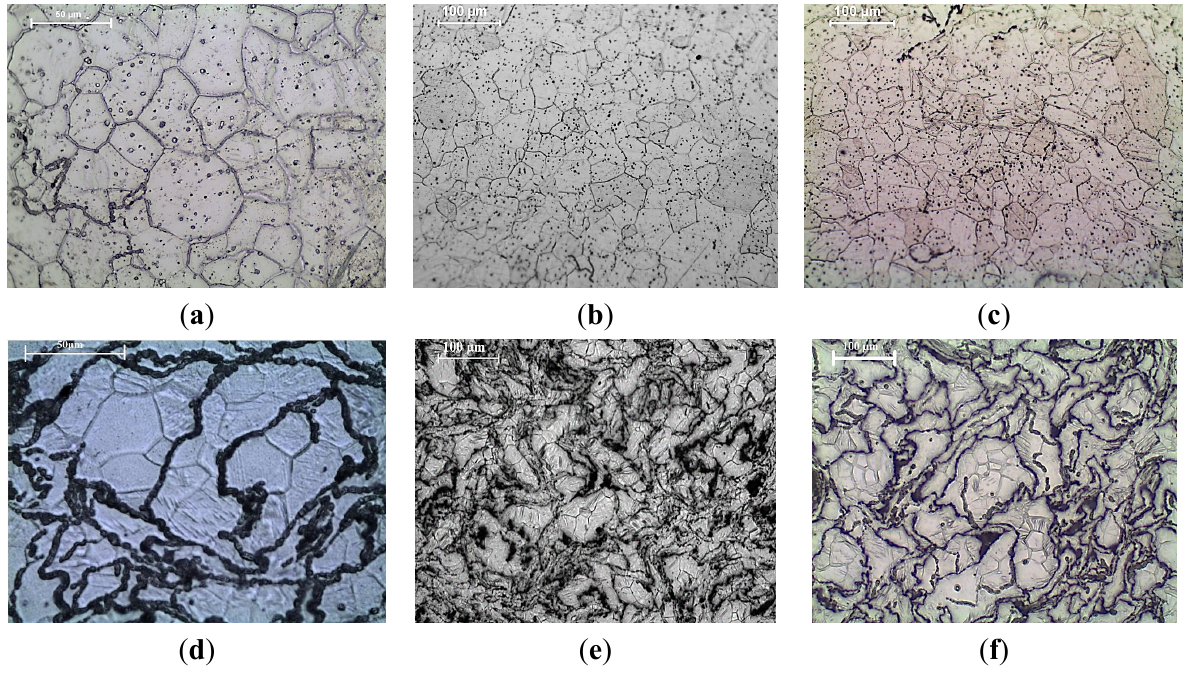
Figure 2. Microscopic images showing grain characteristics of: DMD synthesized ( a ) Pure Magnesium, ( b ) Mg 1.98 TiO 2 , ( c ) Mg 2.5 TiO 2 and PM synthesized ( d ) Pure Mg, ( e ) Mg 1.98 TiO 2 , ( f ) Mg 2.5 TiO 2 . Table 3. Results of microstructure and microhardness studies. Sl. No.